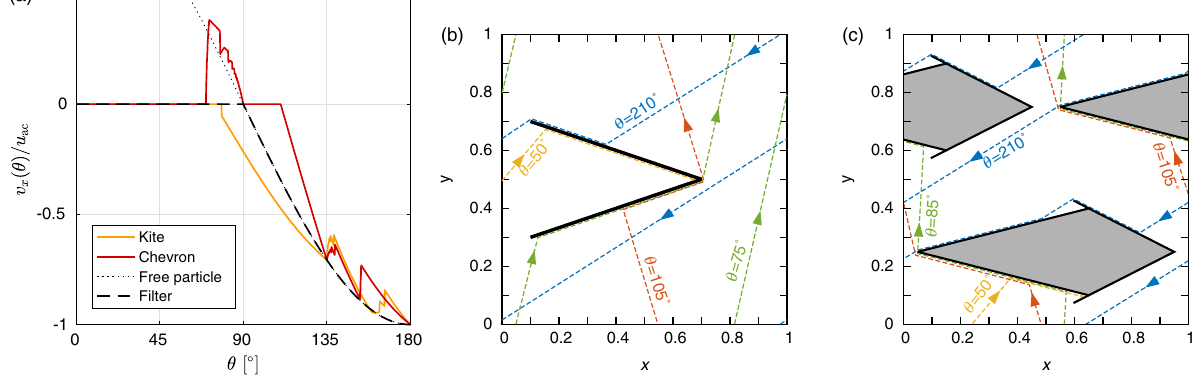
FIG. 4. Angular dependence of the relative velocity of the active particle and the obstacle. (a) shows the velocity in the x direction for the chevron particle shown in (b) (red line) and for the kitelike particle shown in (c) (orange line) along with the curves for the ideal velocity filter (black dashed line) and the completely interaction-free particle (black dotted line). For angles beyond 180°, these curves extend symmetrically. (b) and (c) show trajectories of the relative coordinate for selected angles θ to the x axis. Except for θ ¼ 50 °, where particles get trapped, we show only the periodic part of trajectories, discarding the initial, transient dynamics. Parameters are μ = μ 0 . 1 and f 0 p a ¼ ex ¼